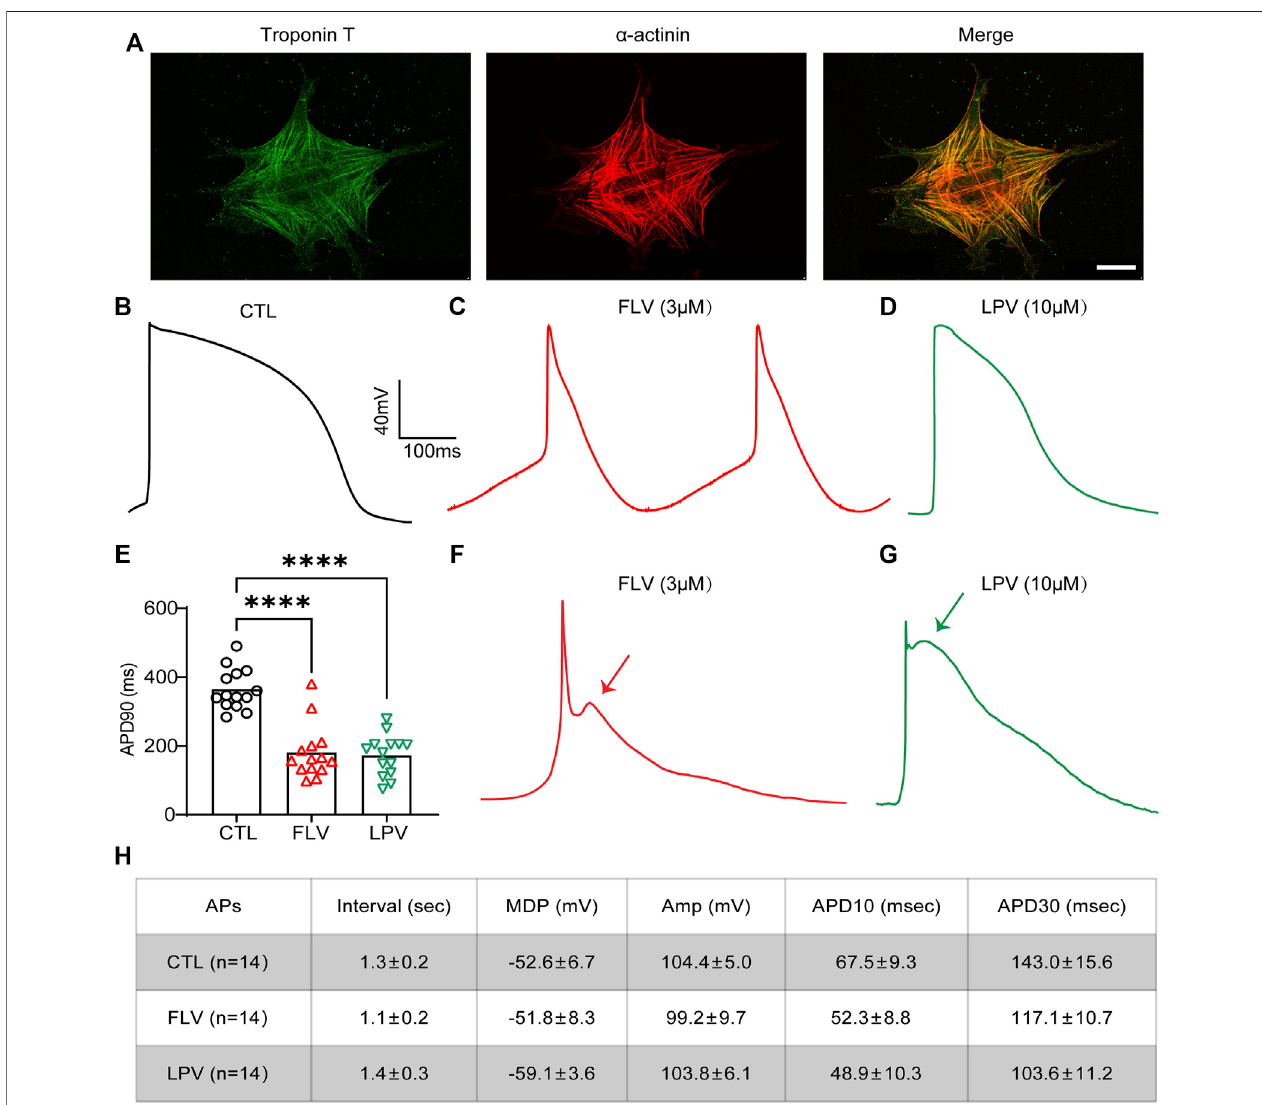
FIGURE 6 | FLV and LPV shorten the action potential duration (APD) and induce early after-depolarizations (EADs) in the human-induced pluripotent stem cell – derived cardiomyocytes (hiPSC-CMs). (A) Immunostaining images of the speci fi c cardiomyocyte markers troponin T (green) and α -actinin (red) to characterize the generation of hiPSC-CMs. Scale bar: 50 µm. (B,C,D) Representative action potentials (APs) in the absence of (CTL) and after 24 h of FLV (spontaneous APs) and LPV (evoked APs) incubation. (E) Statistical APD90 of 24-h FLV and LPV incubation compared with CTL, respectively, n = 14. (F,G) Representative APs after transient effects (within 1 hour) of FLV and LPV, respectively. Arrowsrepresent the induction of the EADs. (H) Text for details of action potentials (APs). Interval, spontaneous rate interval; MDP, maximum diastolic potential; Amp, amplitude; APD, AP duration at different levels of repolarization.